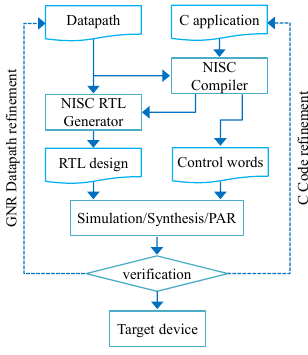
Figure 6. NISC tool set generic design